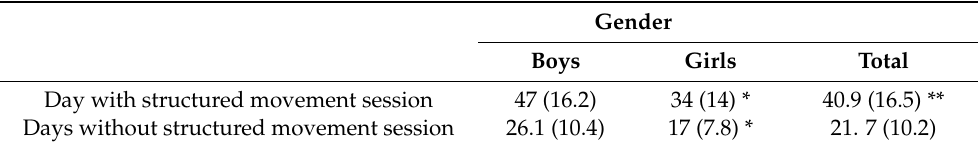
Table 2. Mean (standard deviation) minutes of MVPA on school days with ( n = 1) versus without ( n = 4) structured movement